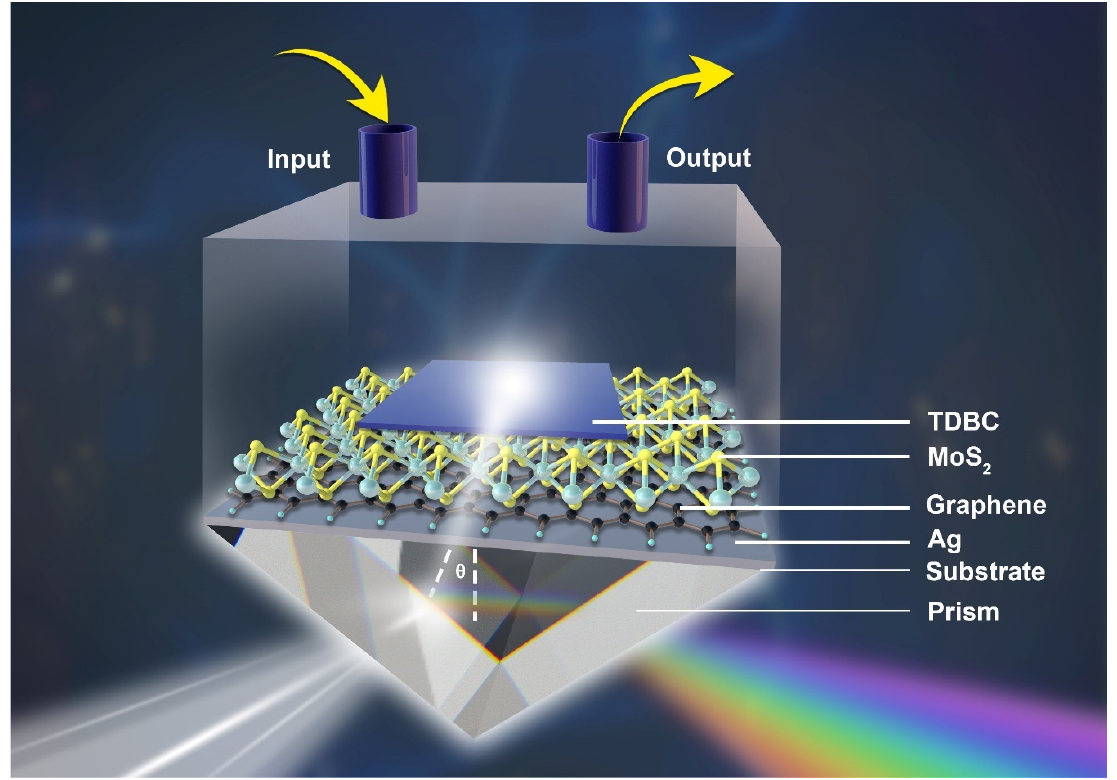
Figure 1. Diagrammatic sketch of the SPR sensor based on van der Waals heterojunction sensitization.